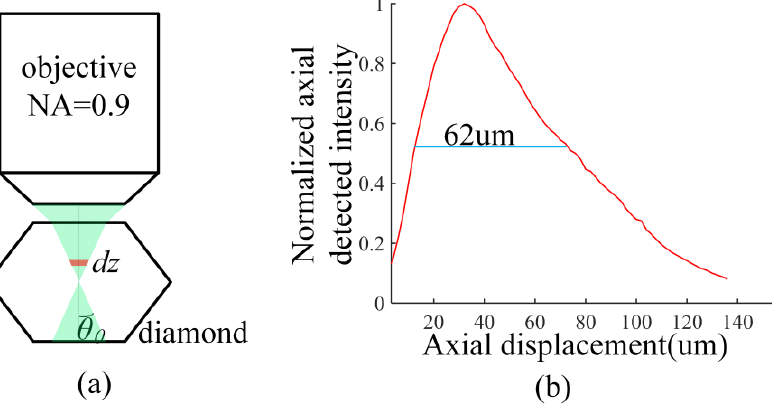
Figure 4. ( a ) The integration of objective lens (NA 2 = 0.9, 100 × ) and micro-diamond in the confocal system. The diagram is not drawn to actual scale for clarity. ( b ) The detected axial optical sectioning property of the confocal system.